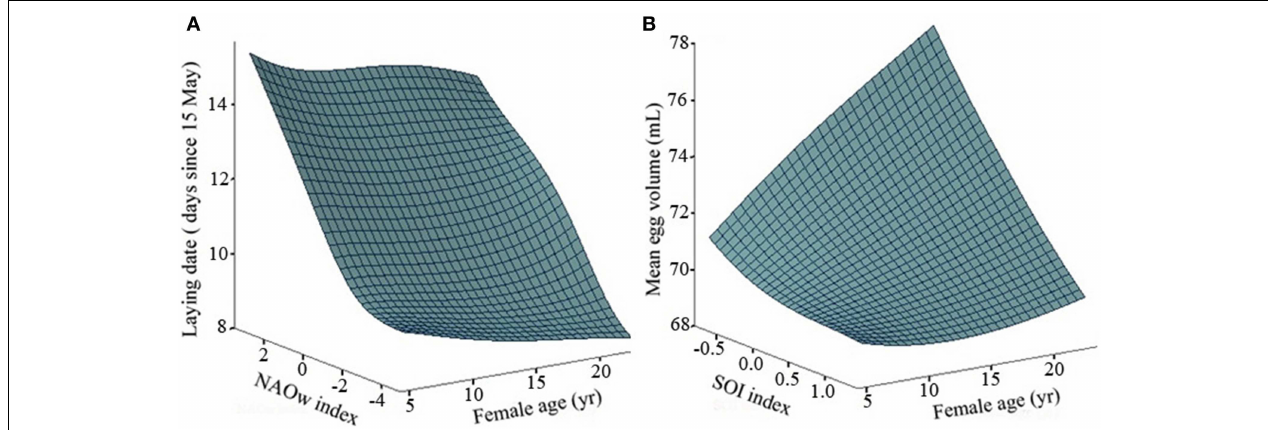
FIGURE 1 | Smoothing regression surfaces taking into account the effects of age and the climatic index that explain the greatest amount of variance for each breeding parameter. (A) NAO w index for laying date, (B) SOI index for egg volume.